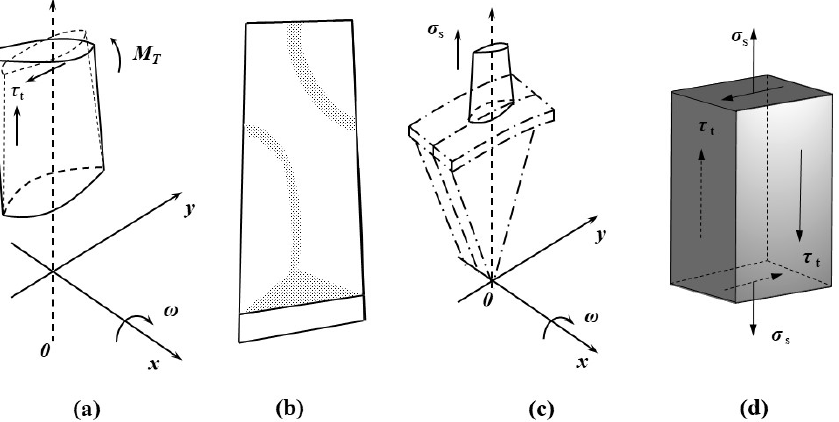
Figure 1. Stress state of blade under torsional vibration. ( a ) Torsional stress of blade; ( b ) Deformation of blade; ( c ) Tensile stress of blade; ( d ) Stress state.